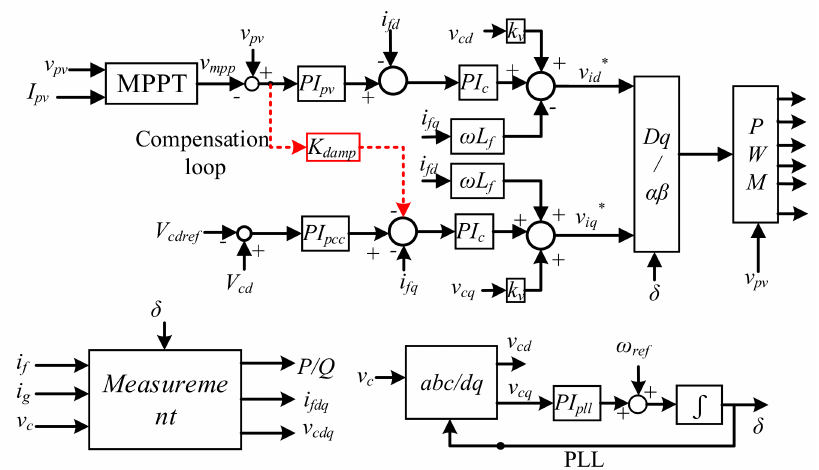
Figure 6. Control system for grid-connected PV inverter with proposed compensation